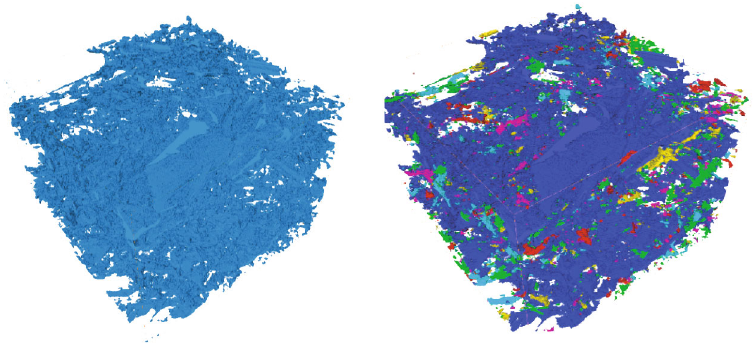
Figure 9: Nano CT pro fi le of the Chang 7 reservoir rock samples.